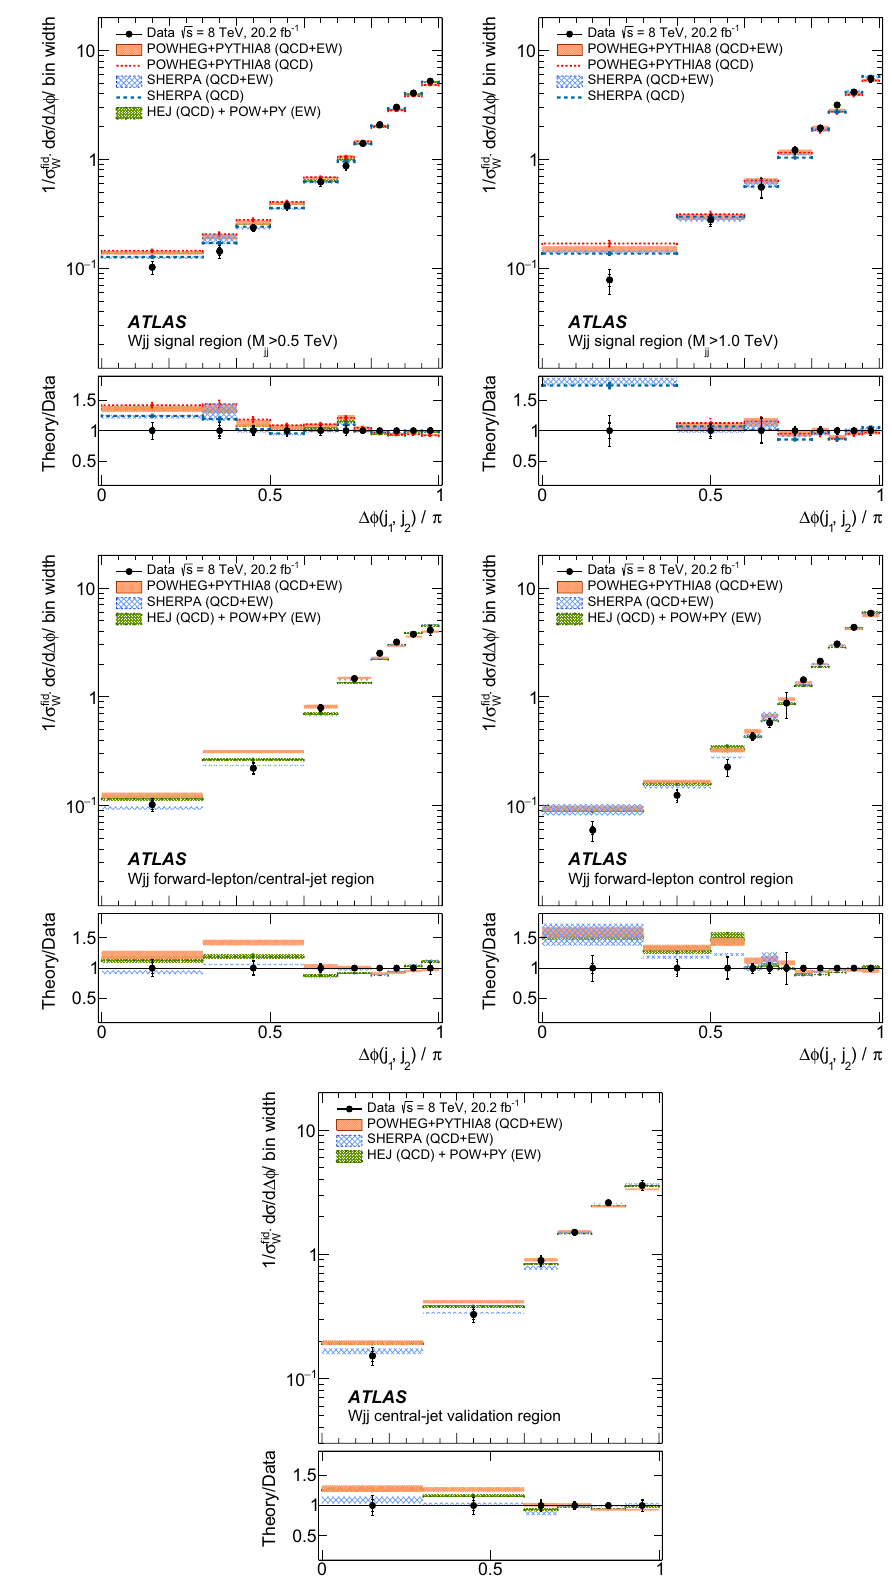
Fig. 49 Unfolded normalized differential W jj production cross sections as a function of (cid:6)φ( j , j ) in the signal, 1 2 high-mass signal, forward-lepton/central-jet, forward-lepton, and central-jet fiducial regions. Both statistical ( inner bar ) and total ( outer bar ) measurement uncertainties are shown, as well as ratios of the theoretical predictions to the data (the bottom panel in each